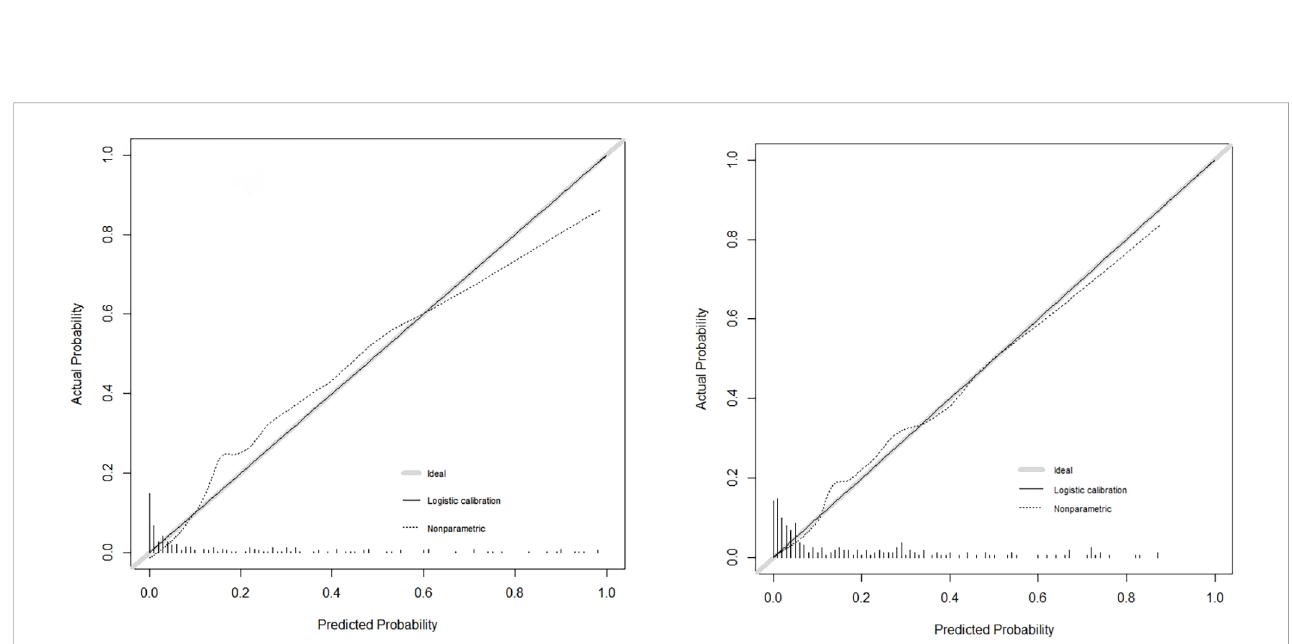
FIGURE 3 Calibration plots of the nomogram for the probability of the development group and validation